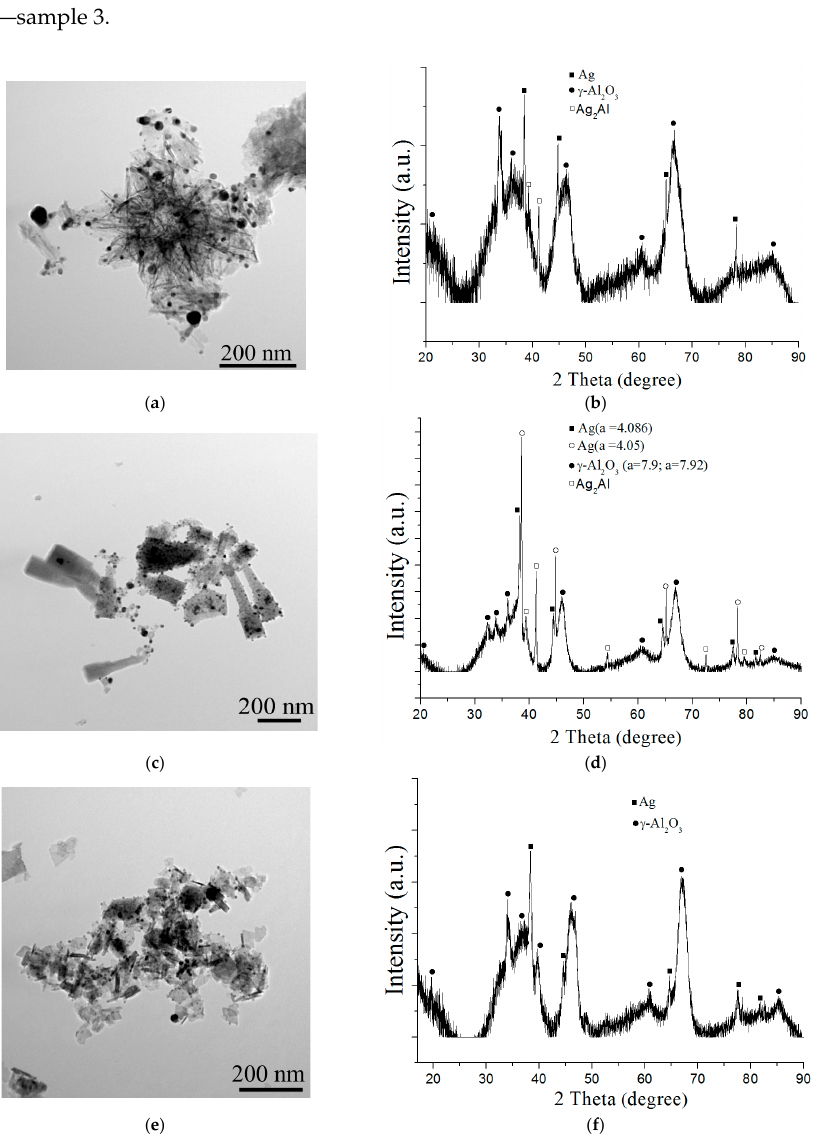
Figure 11. TEM images ( а , c , e ) and XRD pattern ( b , d , f ) of the γ -Al 2 O 3 /Ag nanostructures: ( а , b )—sample 4; ( c , d )—sample 5; ( e , f )—sample 6. Thermal treatment of nanostructures also reduced the average size of the silver nanoparticles to 12 nm (Figure 12). The migration of silver particles and reduction in their size could be related to the thermally induced mobility of silver nanoparticles at tem- peratures above 200 °C [53].